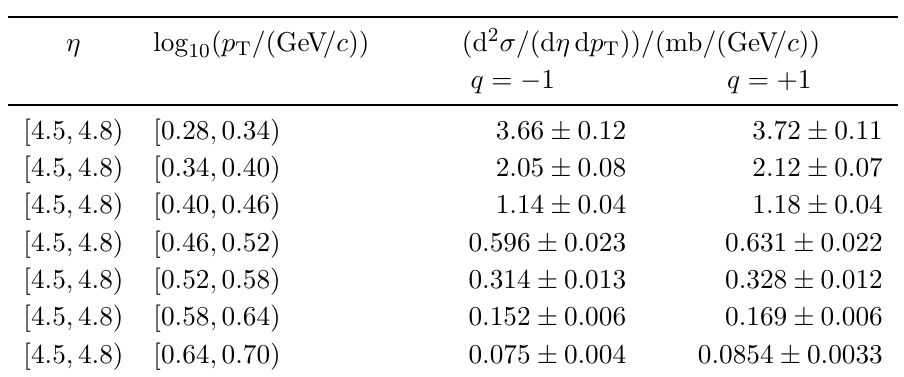
Table 3. Differential cross-sections of prompt inclusive production of long-lived positively and negatively charged particles as a function of transverse momentum and